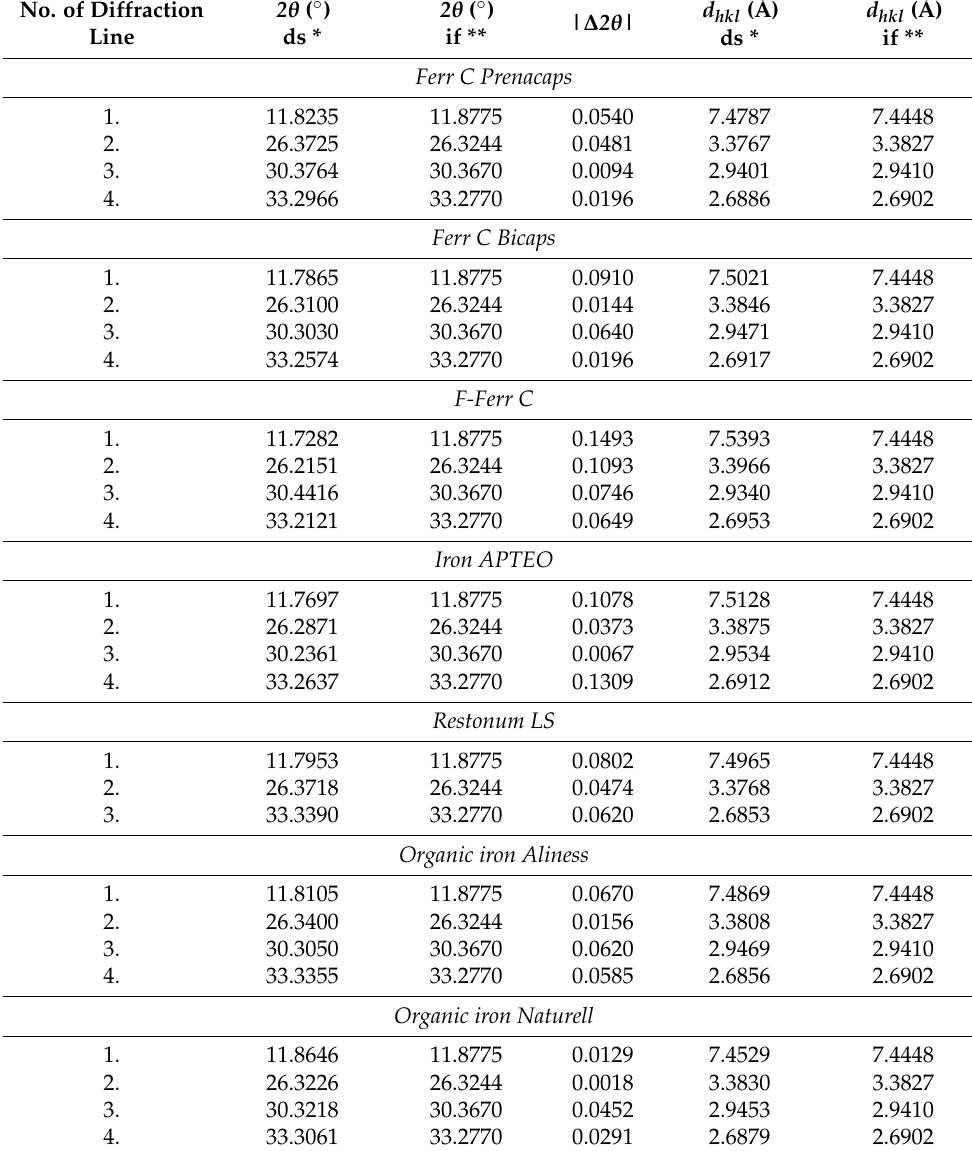
Table 3. Comparison of experimental data of dietary supplements containing iron (II) fumarate with the experimental data for pure iron (II)